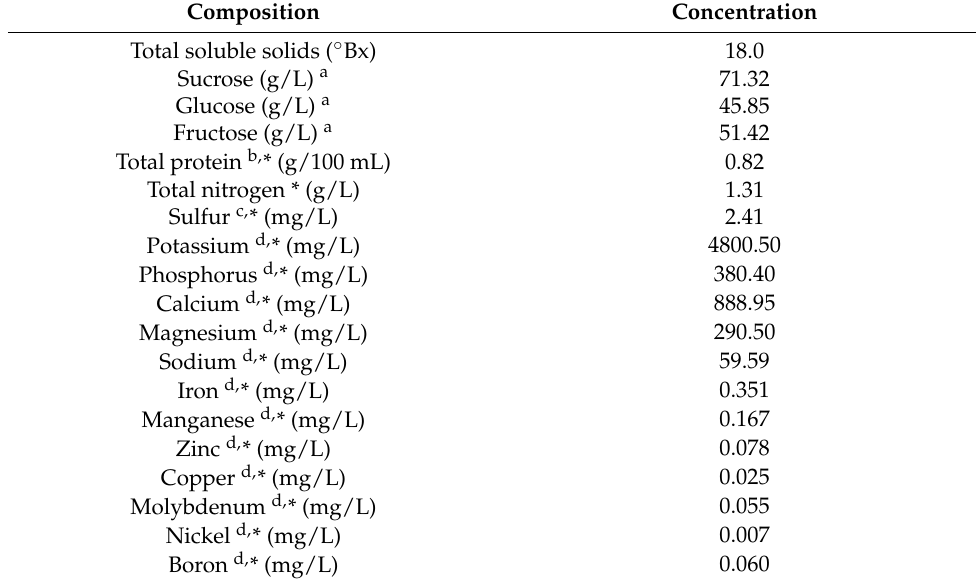
Table 1. The composition of the sweet sorghum stem juice ( cv . KKU 40).